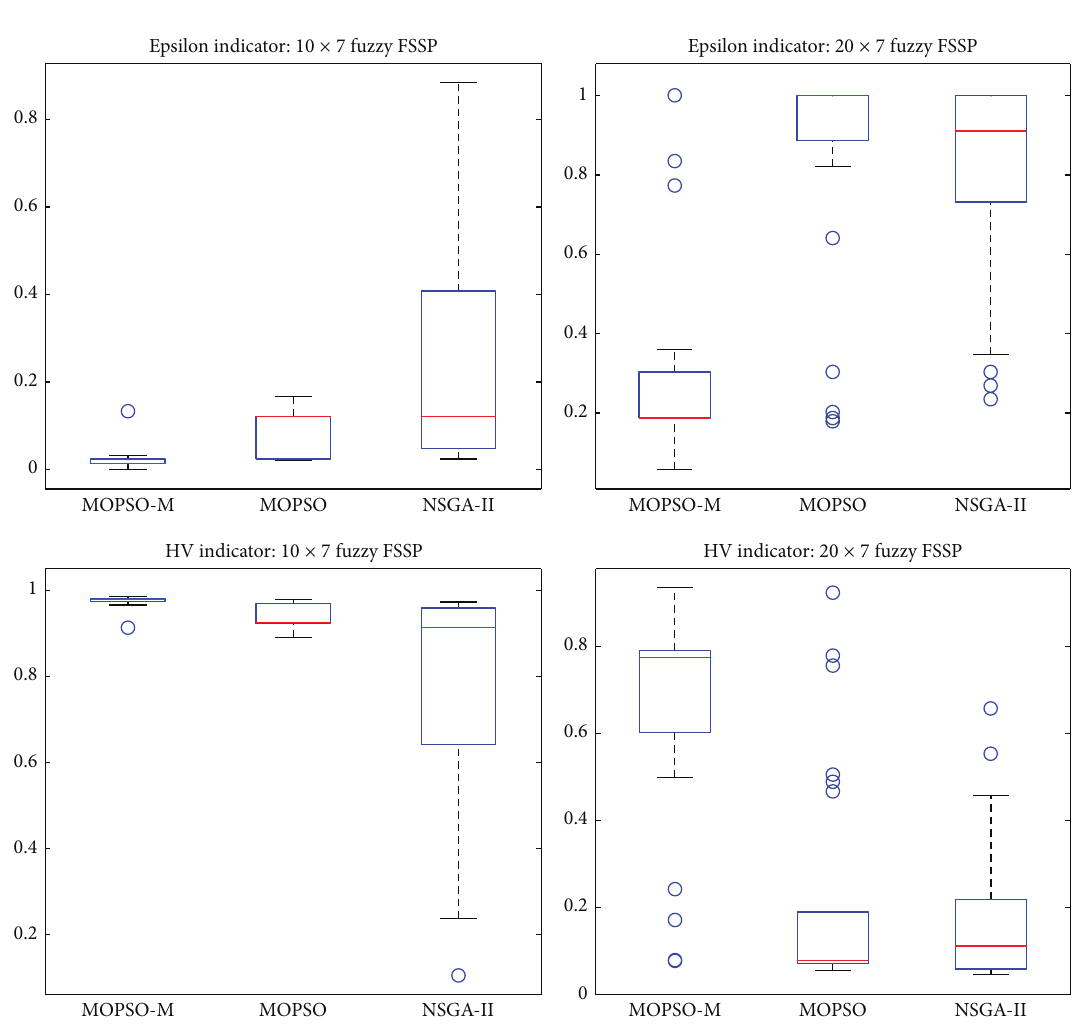
Figure 3: Box plots of the 𝐼 1 𝜀+ and HV indicators obtained by MOPSO-M, MOPSO, and NSGA-II in the two fuzzy FSSPs.